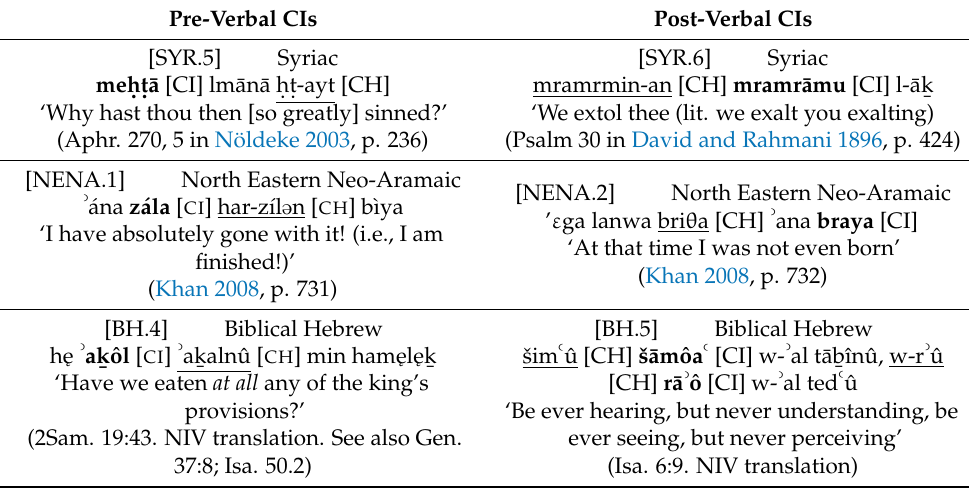
Table 4. CIs in both pre-verbal and post-verbal positions in specific Semitic varieties. Pre-Verbal CIs Post-Verbal